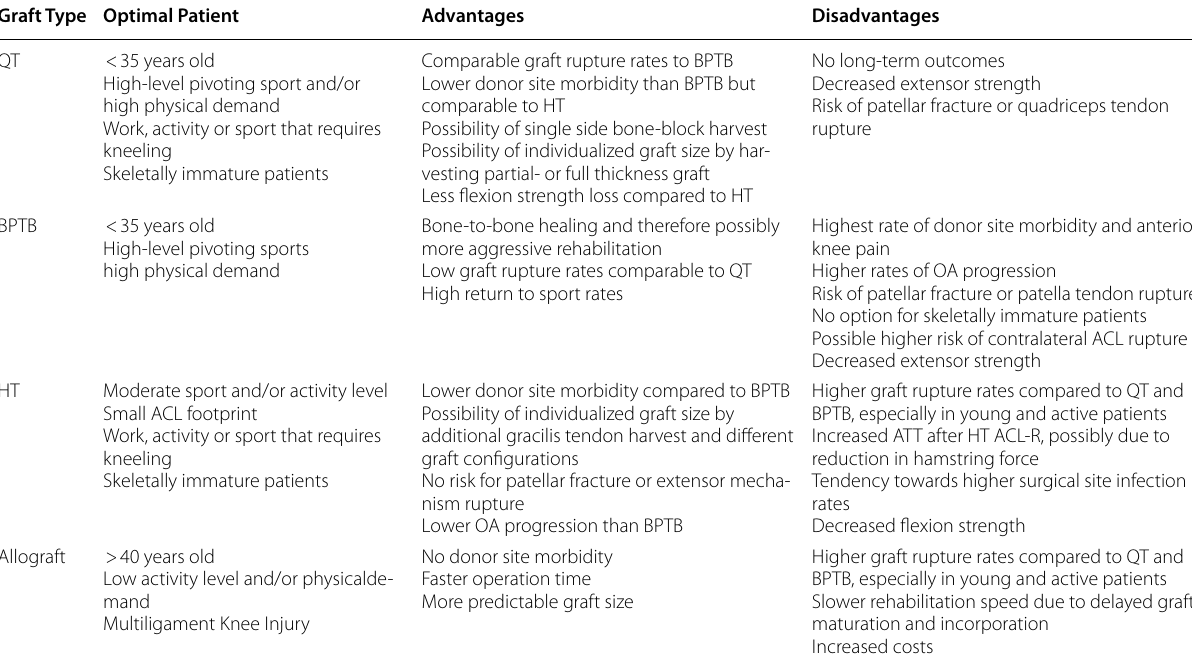
QT Quadriceps Tendon Autograft, BPTB Bone-Patellar-Tendon-Bone Autograft, HT Hamstring Tendon Autograft, ACL-R Anterior Cruciate Ligament Reconstruction, ATT Anterior Tibial Translation, OA Osteoarthritis